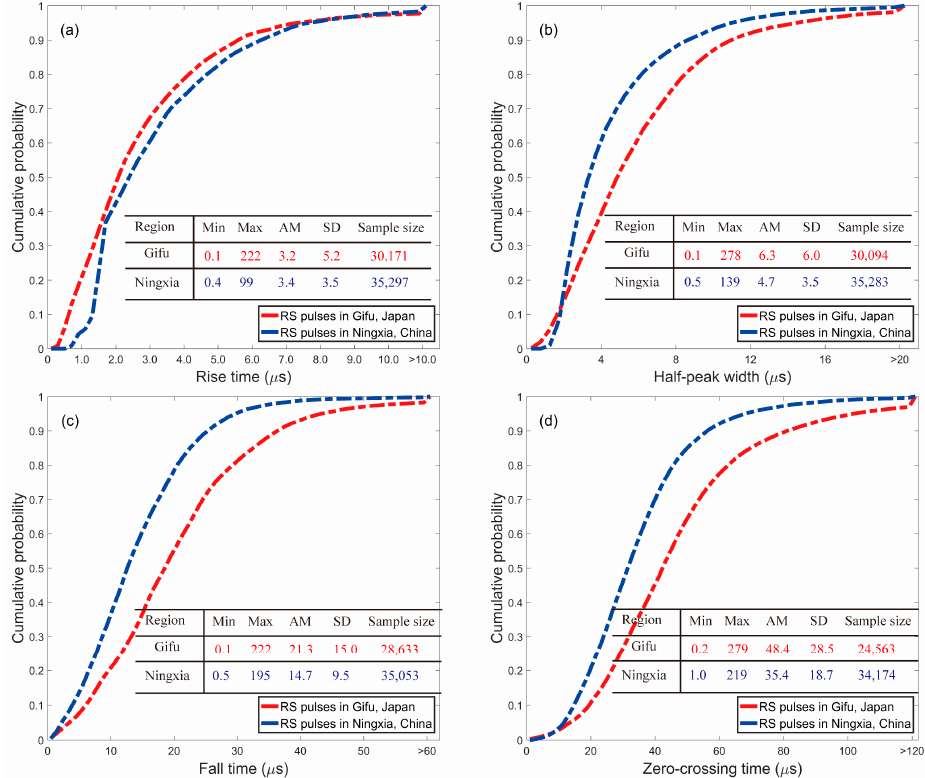
Figure 12. Cumulative probability distribution and corresponding statistical results of the RS pulse parameters: ( a ) rise time; ( b ) half-peak width; ( c ) fall time; ( d ) zero-crossing time. Here, Min, Max, AM, and SD are abbreviations for Minimum, Maximum, Arithmetic mean, Standard deviation, respectively.